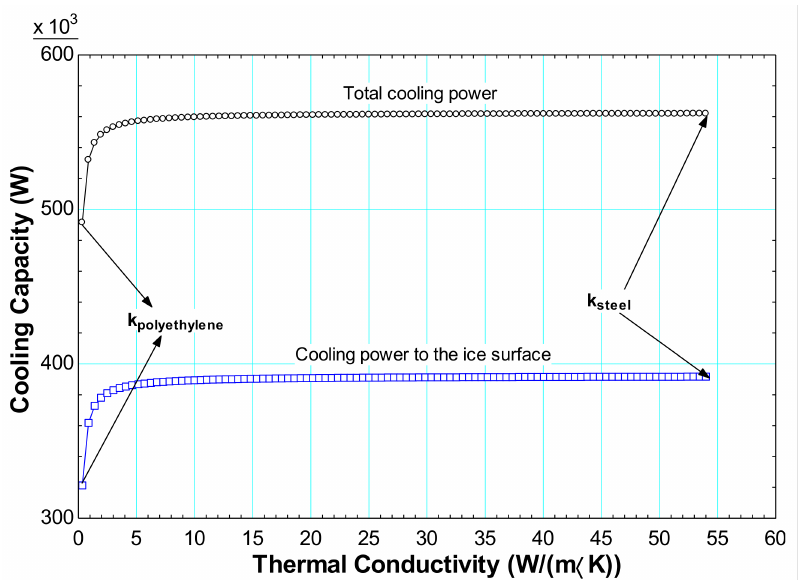
Figure 8. Cooling performance with different types of tube